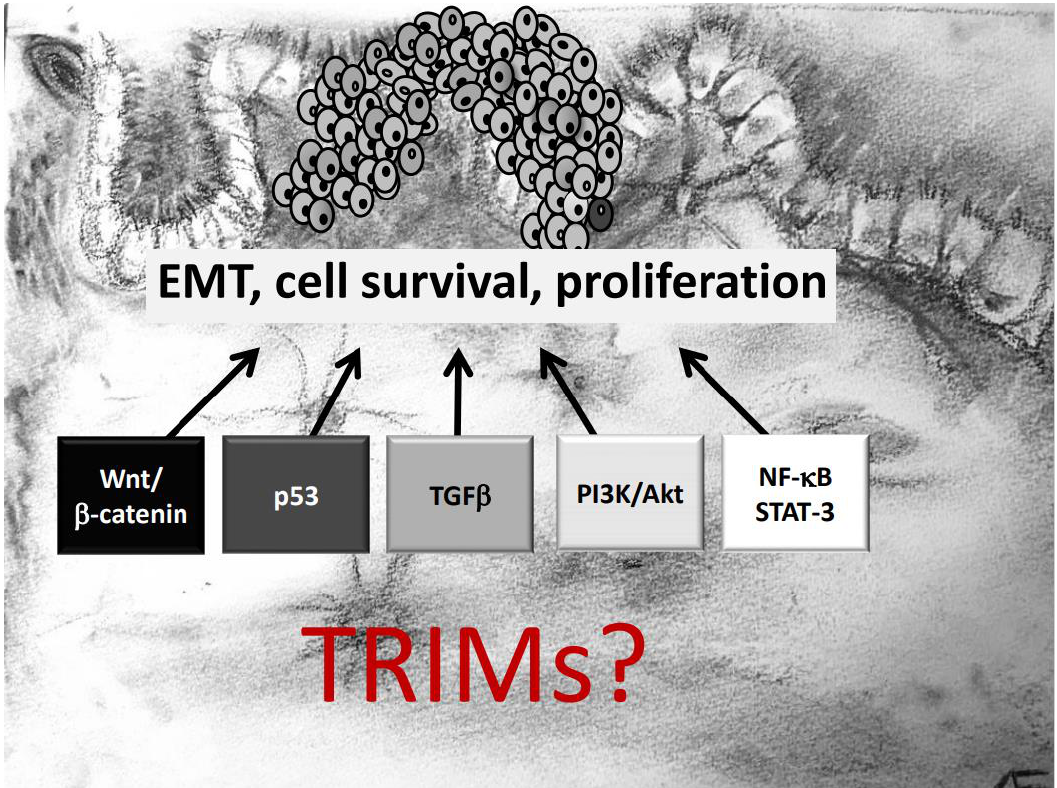
Figure 1. TRIM proteins can affect development and progression of colorectal cancer (CRC) via modulation of diverse oncogenic signaling pathways critically involved in epithelial–mesenchymal transition (EMT), survival, and proliferation of CRC cells.